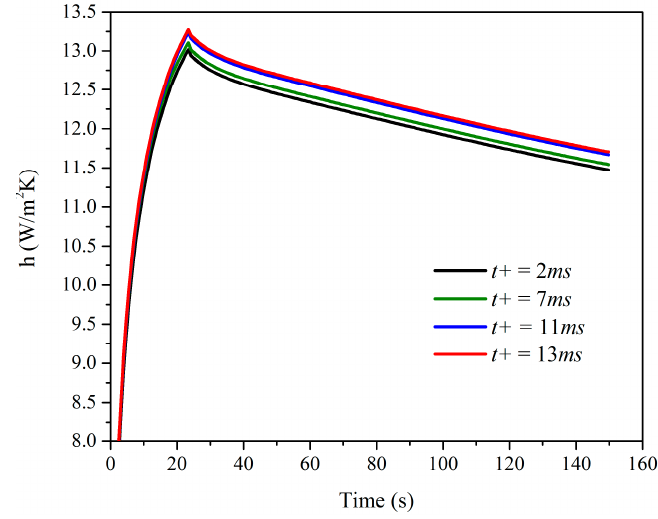
Figure 6. Heat transfer coefficient ( h ) in relation to time.